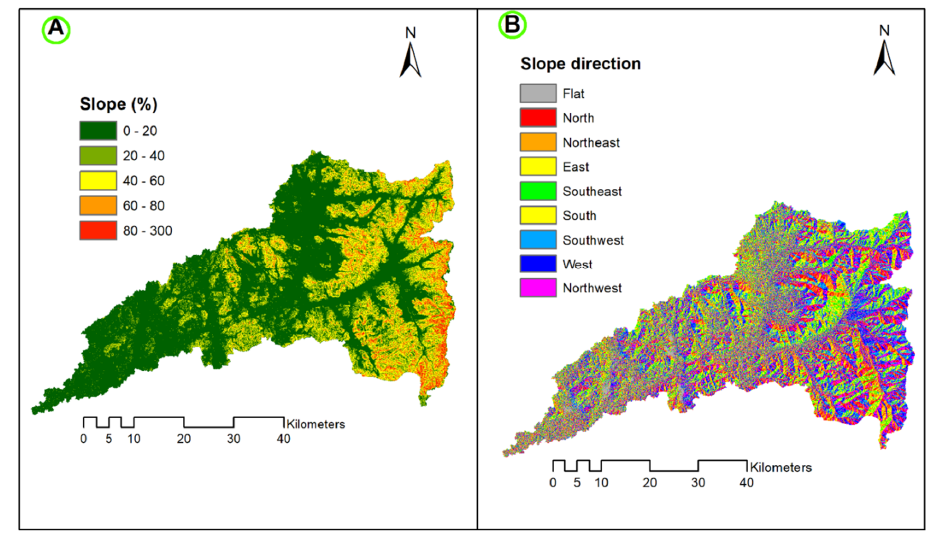
Figure 6. ( A ) Slope map of the study area, ( B ) aspect map of the study